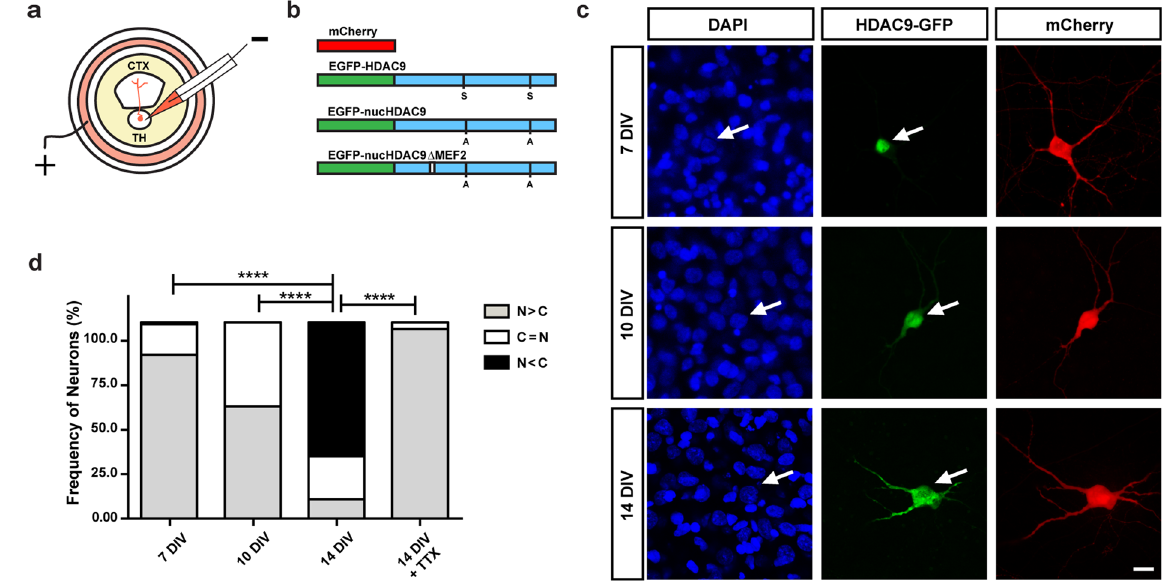
Figure 2. Subcellular localization of HDAC9-EGFP fusion protein in TC organotypic co-culture preparations. ( a ) Experimental set-up of the co-culture preparation and electroporation into thalamic cells. ( b ) Schematic representation of the plasmids used in the present study (see the methods). ( c ) Representative thalamic neurons at 7, 10 and 14 DIV. HDAC9-EGFP distribution in the cells can be compared to the cytoplasmic protein mCherry and the nuclear staining of DAPI. Arrows refer to the position of the same cell at a given time point. Scale bar 10 μ m. ( d ) Quantification of subcellular localization of HDAC9 was expressed as the ratio of transfected cells to illustrate HDAC9-EGFP signal concentrated predominantly in the nucleus (N > C), equally in the nucleus and the cytoplasm (N = C) or predominantly in the cytoplasm (N < C). Statistical analysis by overall Chi-square (Chi = 158, with 6 degrees of freedom, p < 0.000001) followed by pairwise Chi-square with Bonferroni correction. **** p <